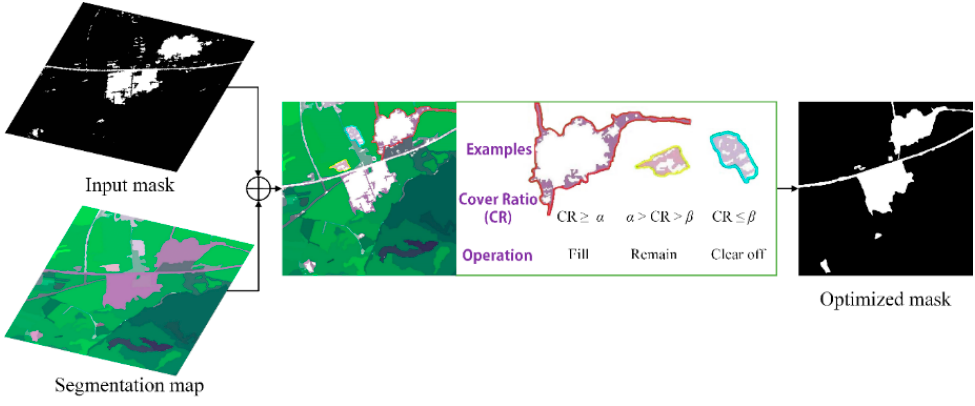
Figure 8. gPb -owt-ucm segmentation at different thresholds, with regions represented by their mean colors. ( a ) Original image; ( b ) threshold = 0.2; ( c ) threshold = 0.5; ( d ) threshold = 0.8.